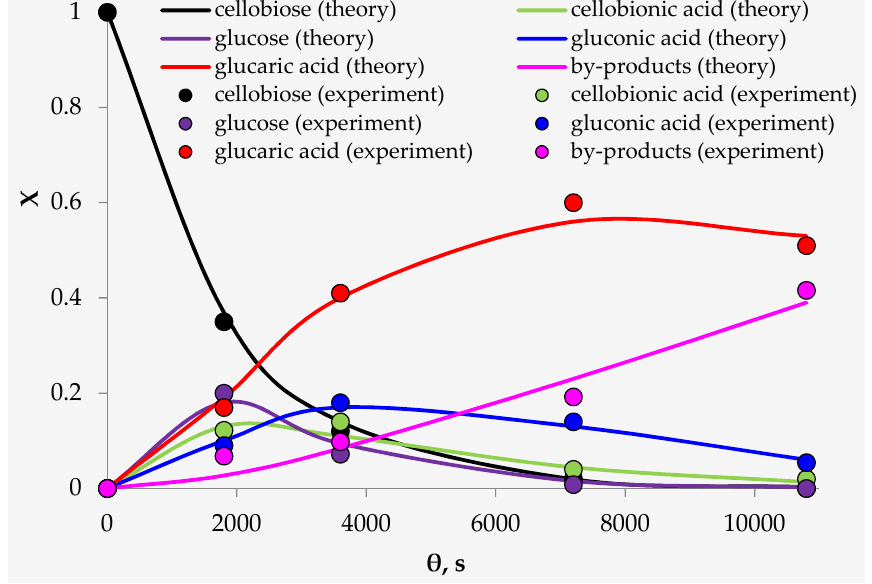
Figure 9. X ~ θ dependence for cellobiose hydrolytic oxidation using 3% Pt/HPS MN270. The rate constant values calculated for cellobiose hydrolytic oxidation according to the model are presented in Table 5. Table 5. Kinetic parameters obtained according to the mathematic model of cellobiose hydrolytic oxidation.